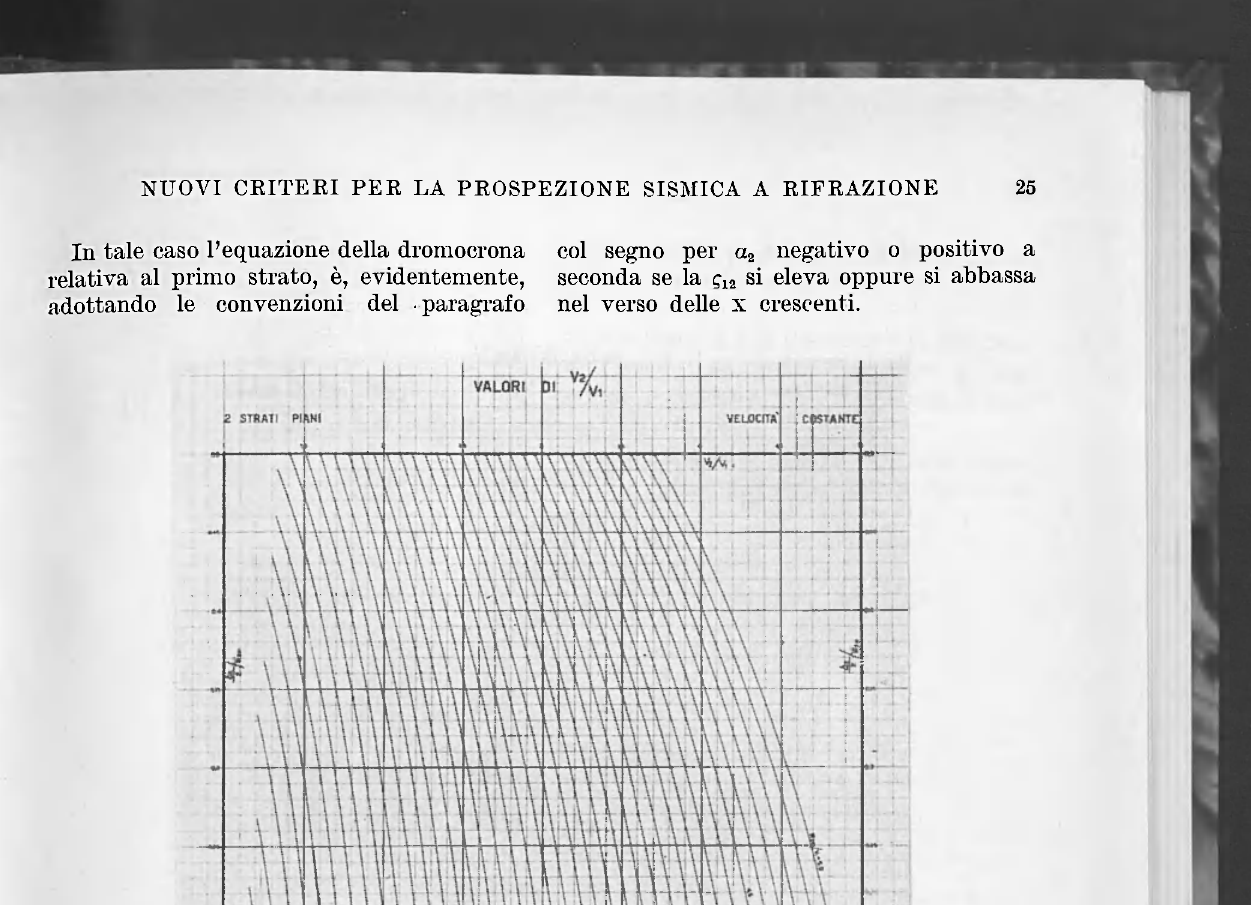
Fig. 3 - Prontuario di calcolo del rapporto VJV 1 noti i valori dei rapporti A 2 /2W 2 , n e W v , l jV 1